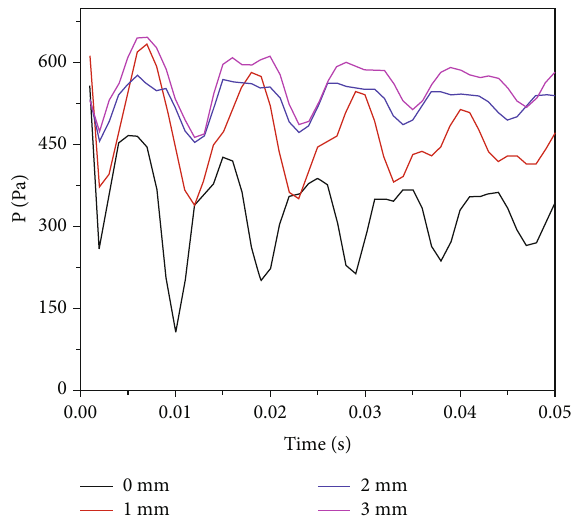
Figure 8: Variation of pressure at the entrance of the glottis with